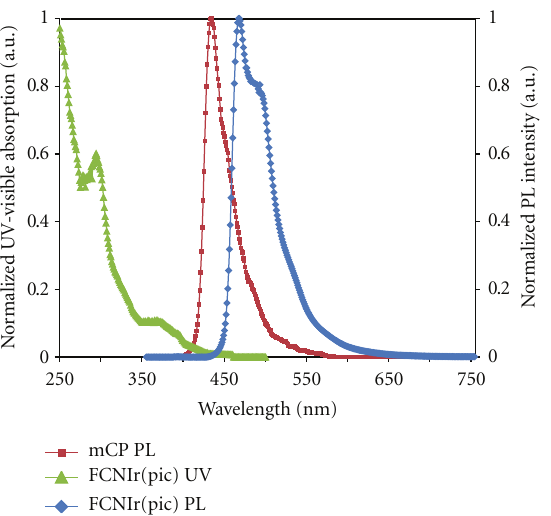
Figure 3: UV-visible absorption and PL spectra of FCNIr(pic) including the PL spectra of mCP.